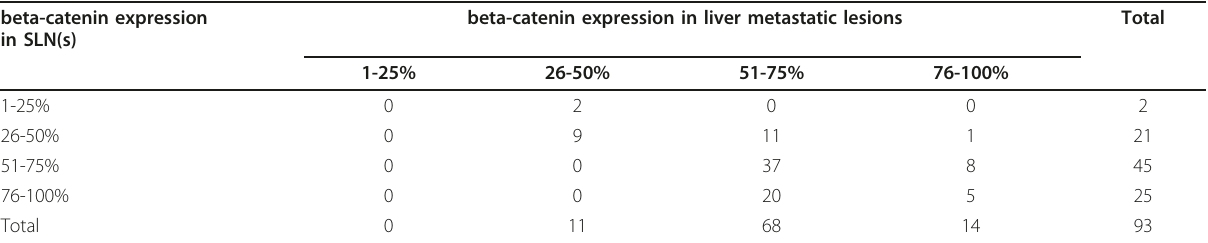
Table 1 Correlation between nuclear beta-catenin expression in SLN(s) and the matched liver metastatic lesions beta-catenin expression in